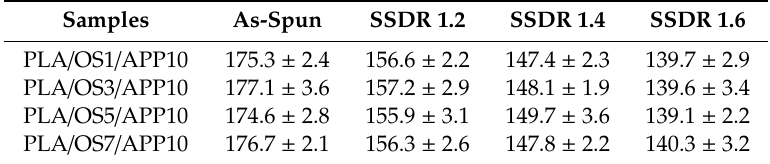
Table 6. Calculated average diameters of multifilament fibers.